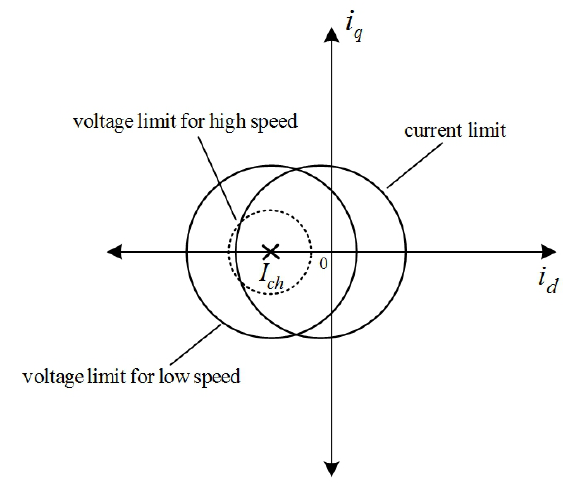
Figure 1. Current limit circle and characteristic